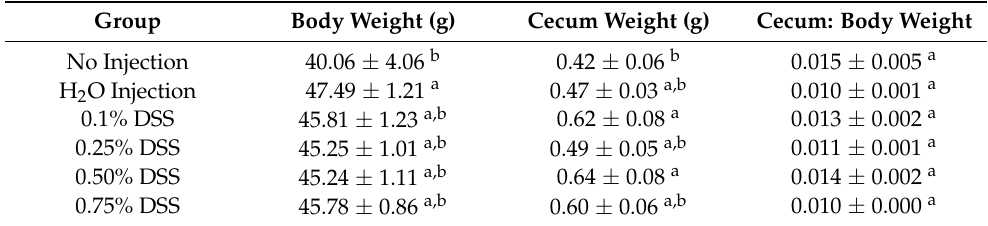
Table 3. The effect of DSS on the body weight, cecum weight, and cecum-to-body-weight ratio.